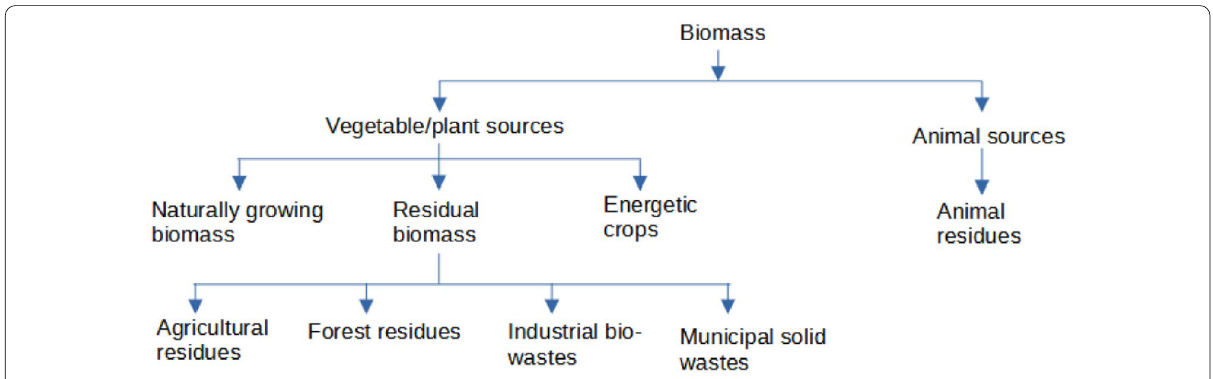
Fig. 3 Biomass classification (Roberts et al.,